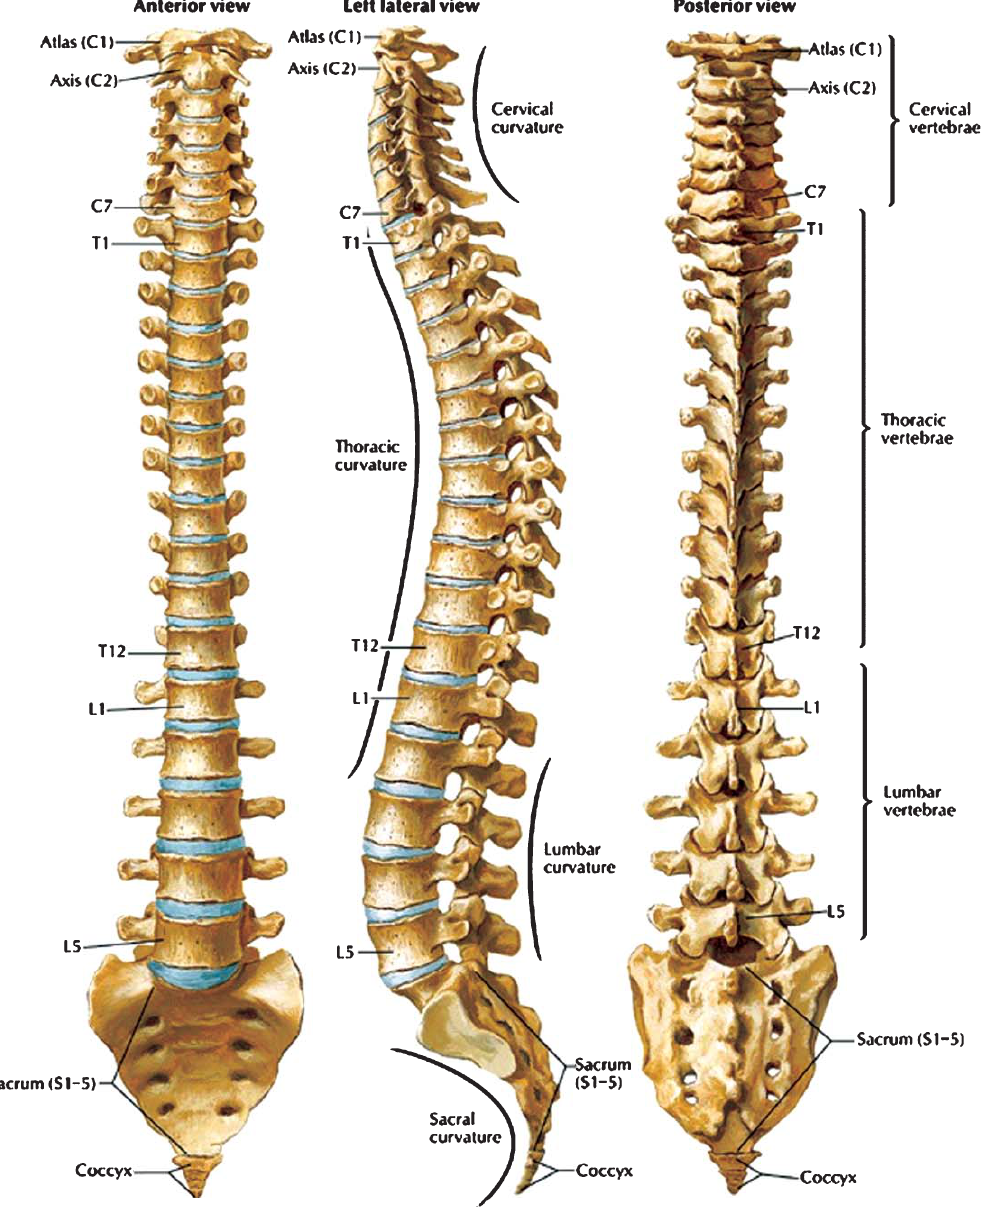
Fig. 1. Structure and regions of a human spine,